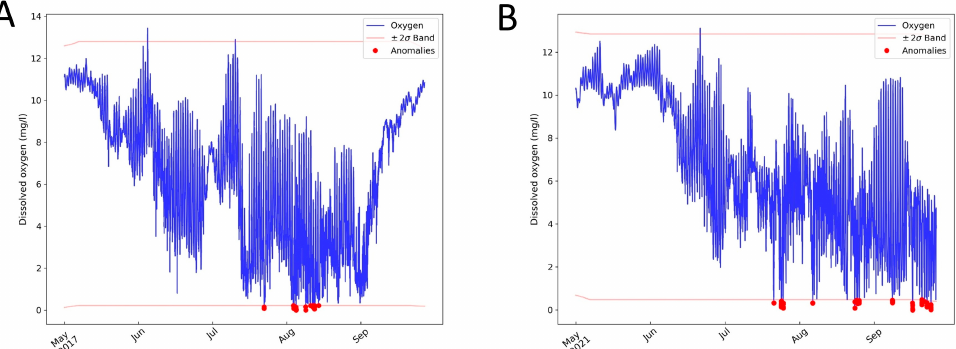
Figure 12. Detection of anomalies in DO data using a simple sliding window approach with a 24 h window. Points were classi fi ed as anomalies (red dots), when the real data points were <µ − 2 σ : ( A ) between 24 July and 16 August 2017; ( B ) between 23 July and 27 September 2021.